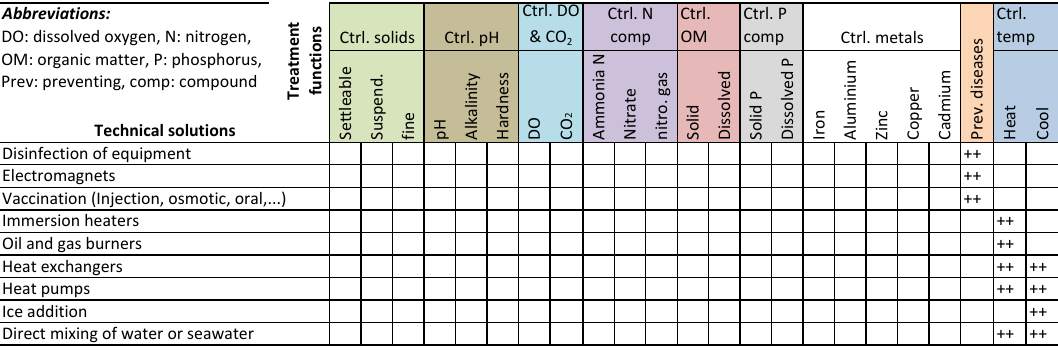
Table 8. QFD matrix presenting how technical solutions for preventing diseases and controlling temperature influence different treatment